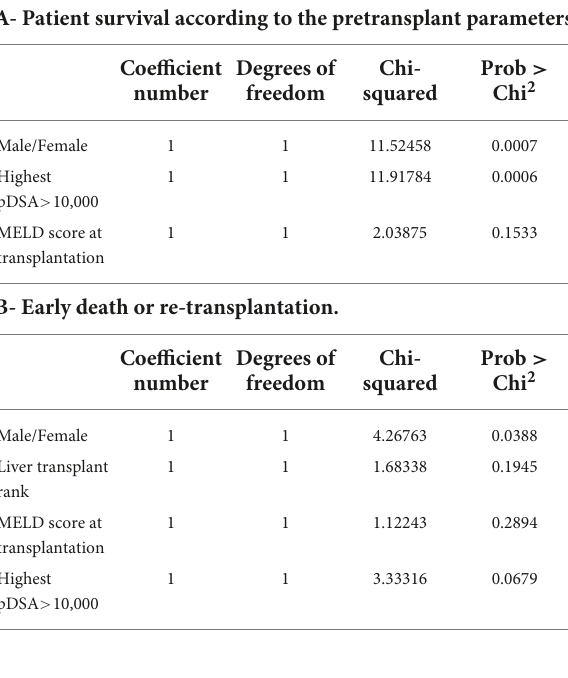
TABLE 6 Multiple regression model for factors involved in patient survival: (A) multiple regression model including all factors associated with the risk of death and available at the time of transplantation ( p < 0.1); (B) multiple regression model including all factors associated with an early risk of death (within 3 months post transplantation) or re-transplantation that were present at the time of transplantation ( p <